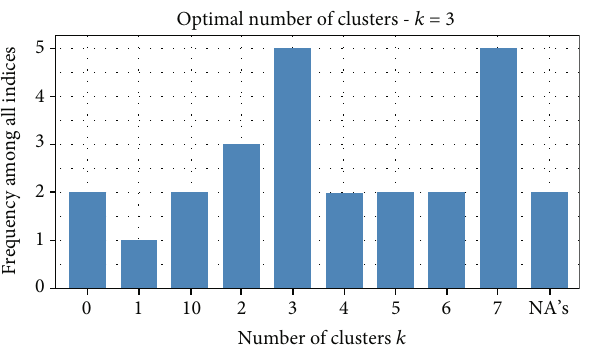
Figure 9: Optimal number of clusters using NbClust R